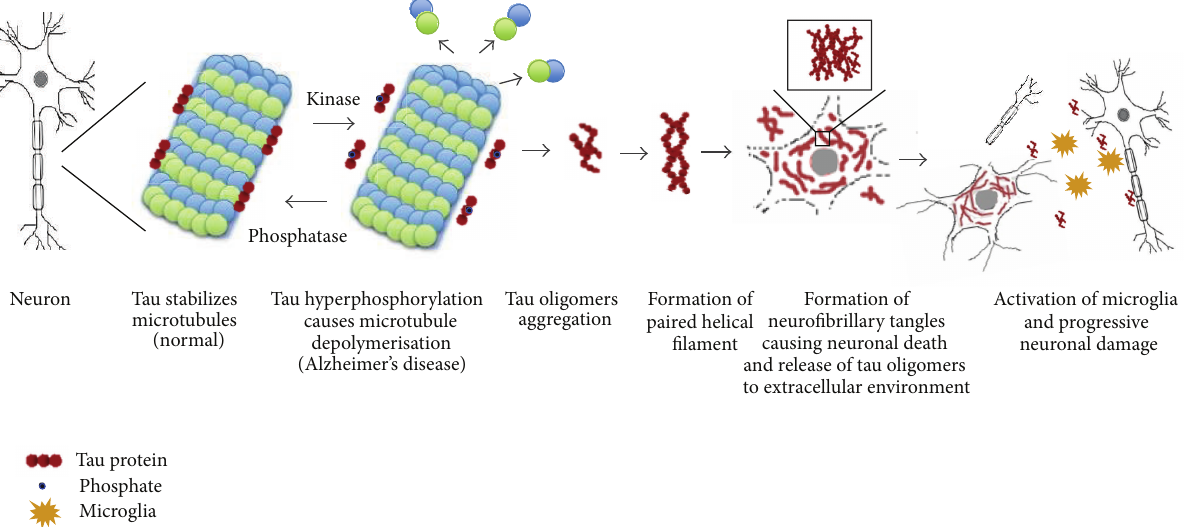
Figure 2: Stabilisation of microtubules by the tau protein is regulated by kinases and phosphatases. Abnormal hyperphosphorylation of tau proteins causes catastrophic microtubule depolymerisation and the formation of insoluble cytoplasmic tau oligomers, which aggregate to formprotomers.Twoprotomerstwistedaroundeachothertoformpairedhelicalfilaments(PHFs),whichassembletoproduceneurofibrillary tangles